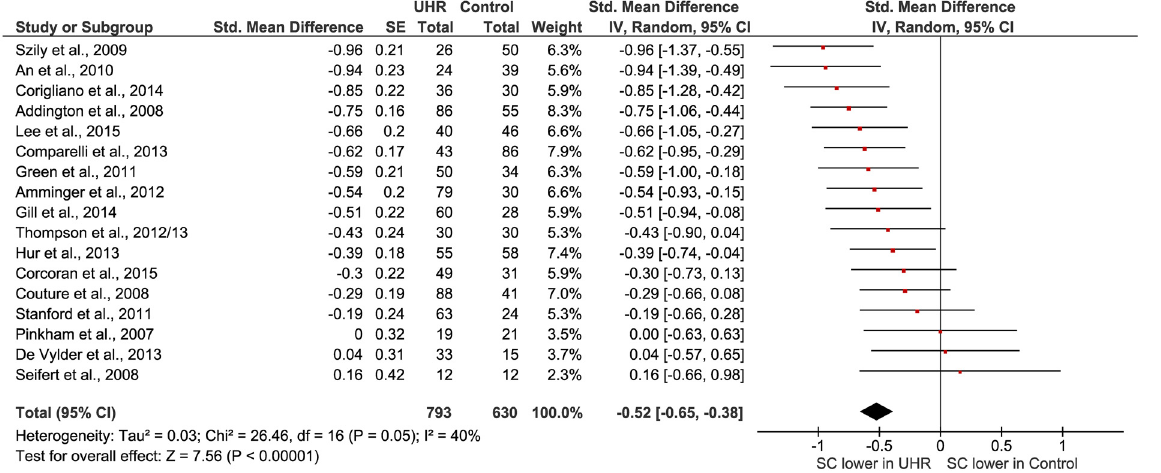
Fig 2. Forest plot of social cognition in UHR versus healthy controls.